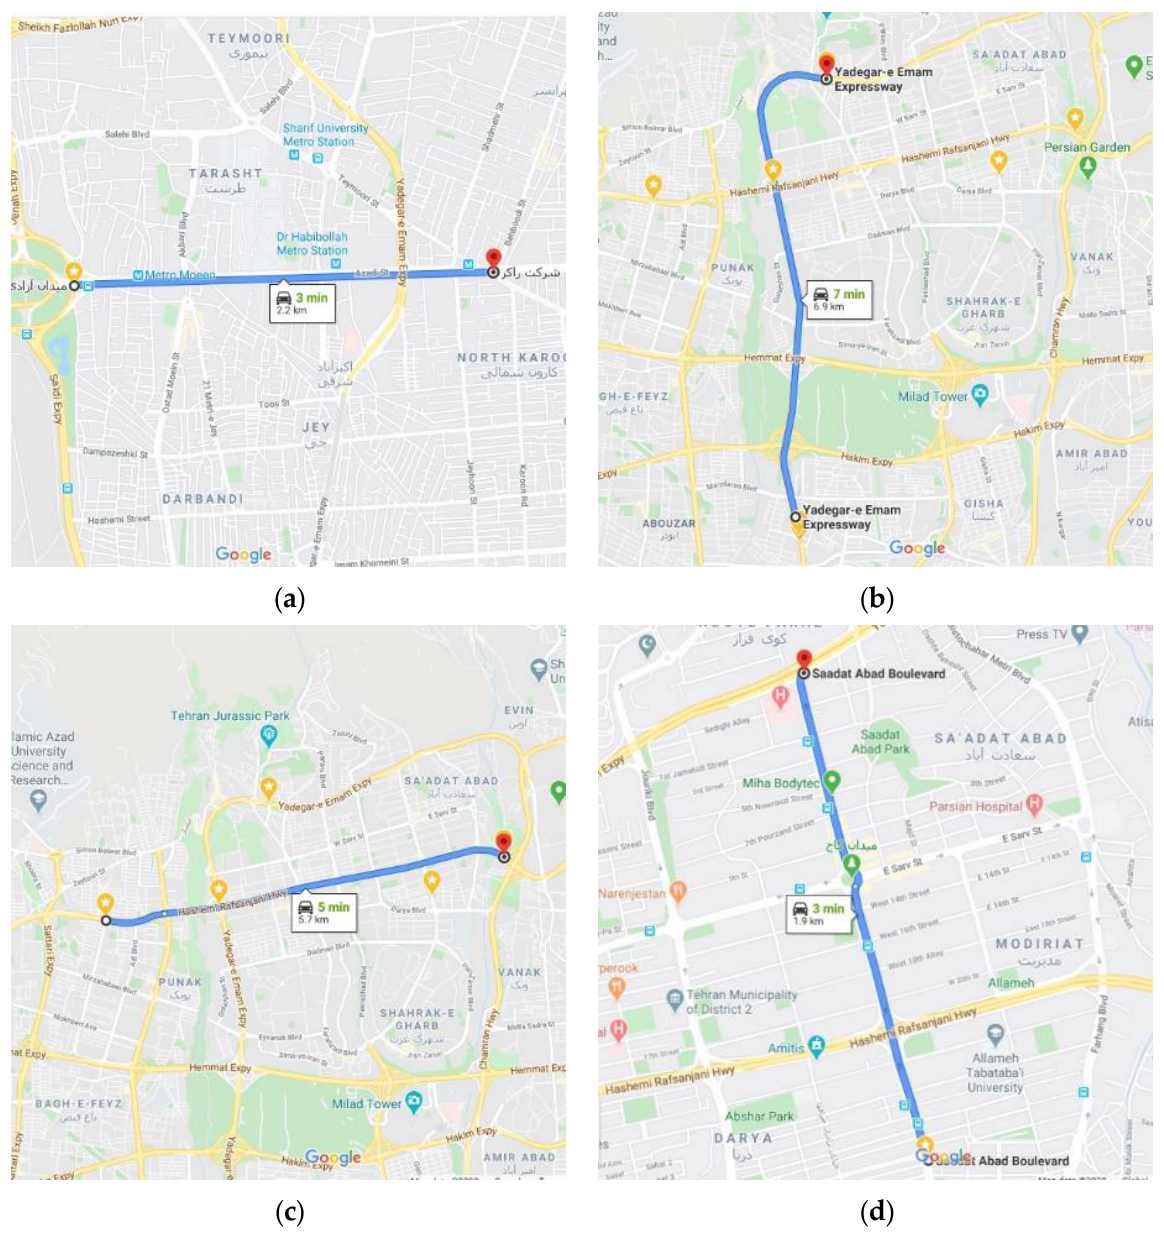
Figure 3. Selected routes for the PEMS tests (source: Google Maps): ( a ) R1; ( b ) R2; ( c ) R3; ( d ) R4. Table 3. Test routes’ characteristics.